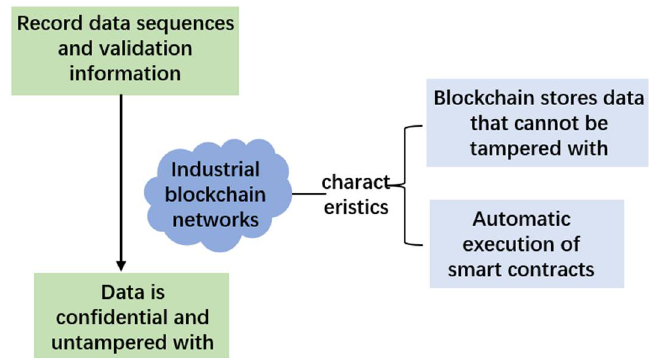
Figure 1. Industrial data security protection scheme.